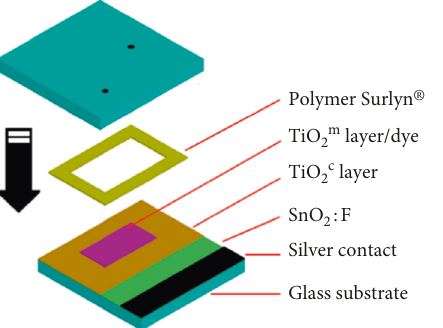
Figure 1: Cell assembly using a Surlyn